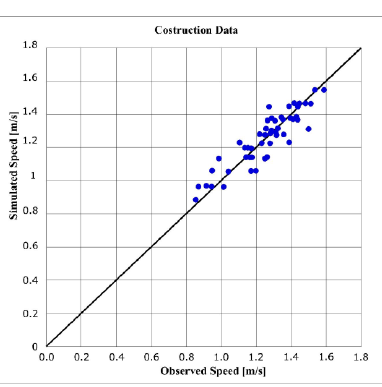
Figure 8. Global model. Comparison between the observed and simulated speeds.